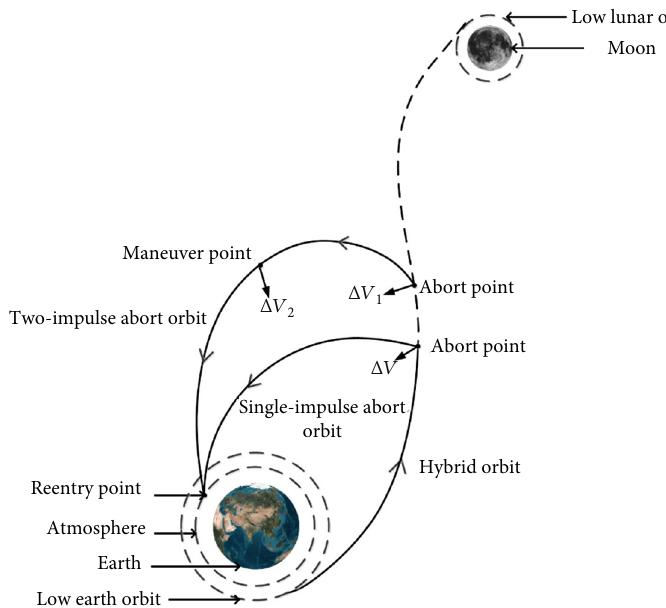
Figure 1: Diagram of direct abort orbits in the Earth-Moon transfer